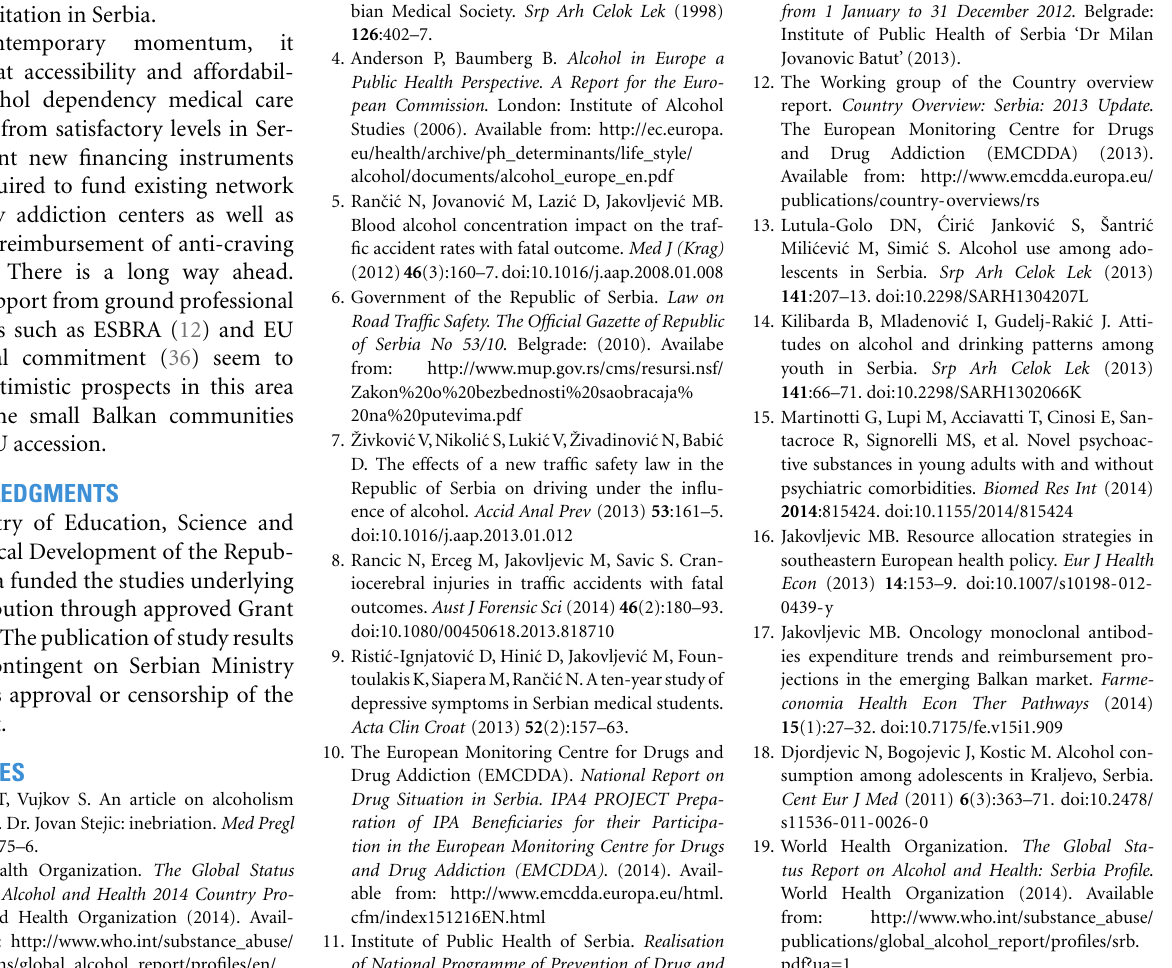
alcohol addiction prevention,medical care, and rehabilitation in